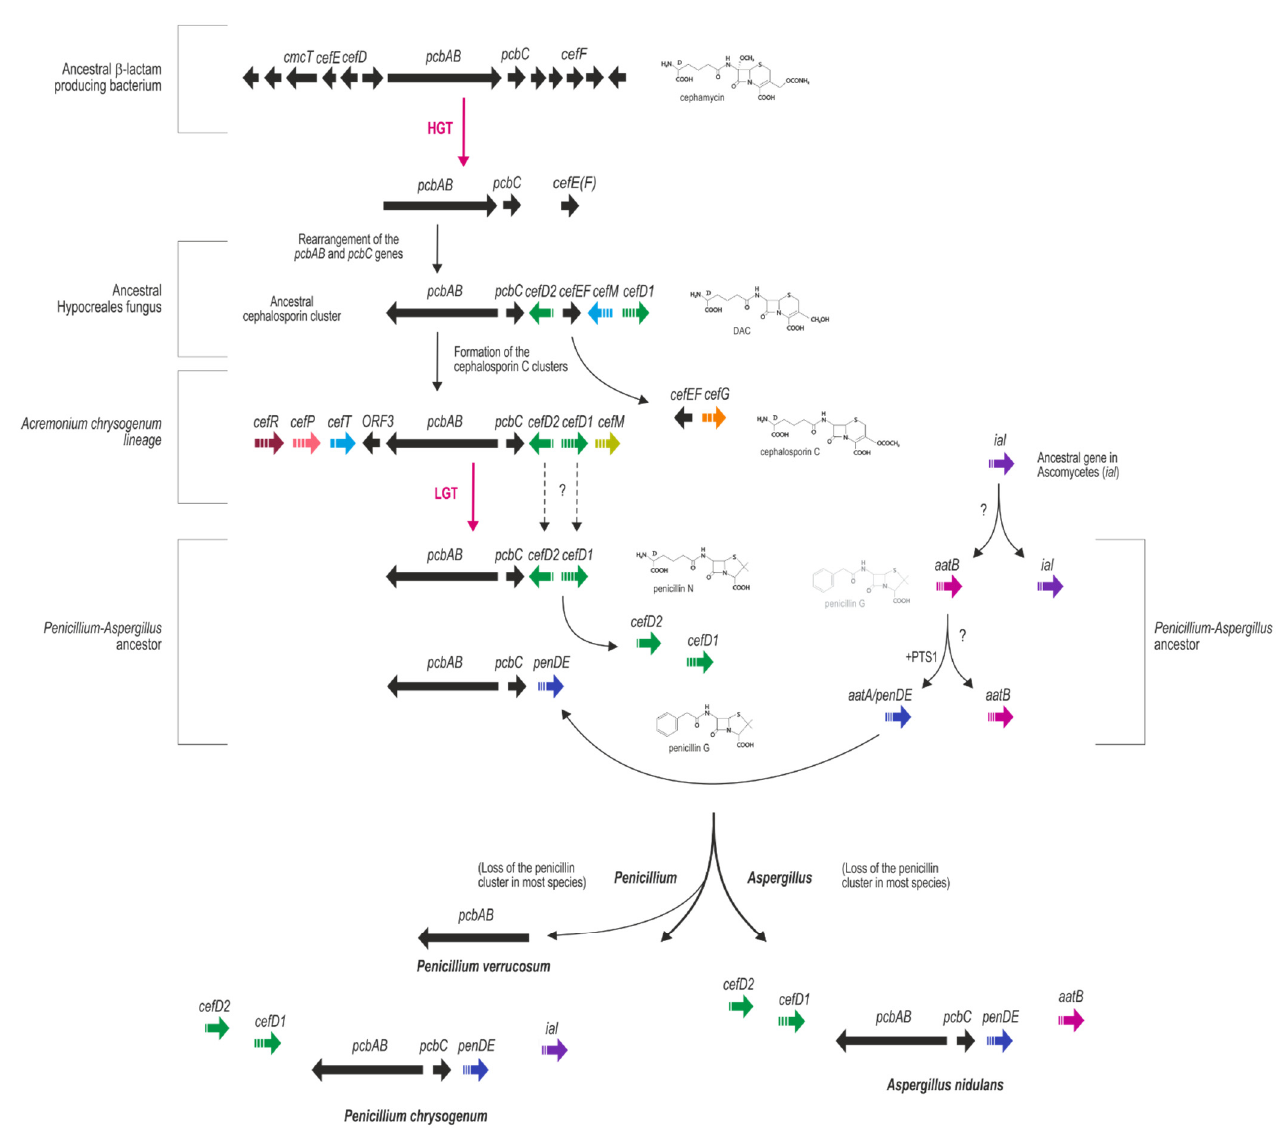
Figure 2. Hypothetic pathway for the formation of the cephalosporin and penicillin gene clusters, which includes one HGT from bacteria to Hypocreales and one LGT from a Hypocreales fungus to an ancestor of Penicillium and Aspergillus (see text for more details). Genes in black are of bacterial origin, and genes in different colors are of eukaryotic origin. Introns are indicated with a white bar. At the right of each cluster is the name and structure of the β -lactam antibiotic that it produces (for old, hypothetical clusters no longer present in current species the antibiotic might have had a different structure). The grey color of penicillin G beside the aatB gene indicates low production of this antibiotic due to the low IAT activity of the cytosolic AatB enzyme. DAC: deacetyl cephalosporin. PTS1: peroxisome targeting sequence type 1.